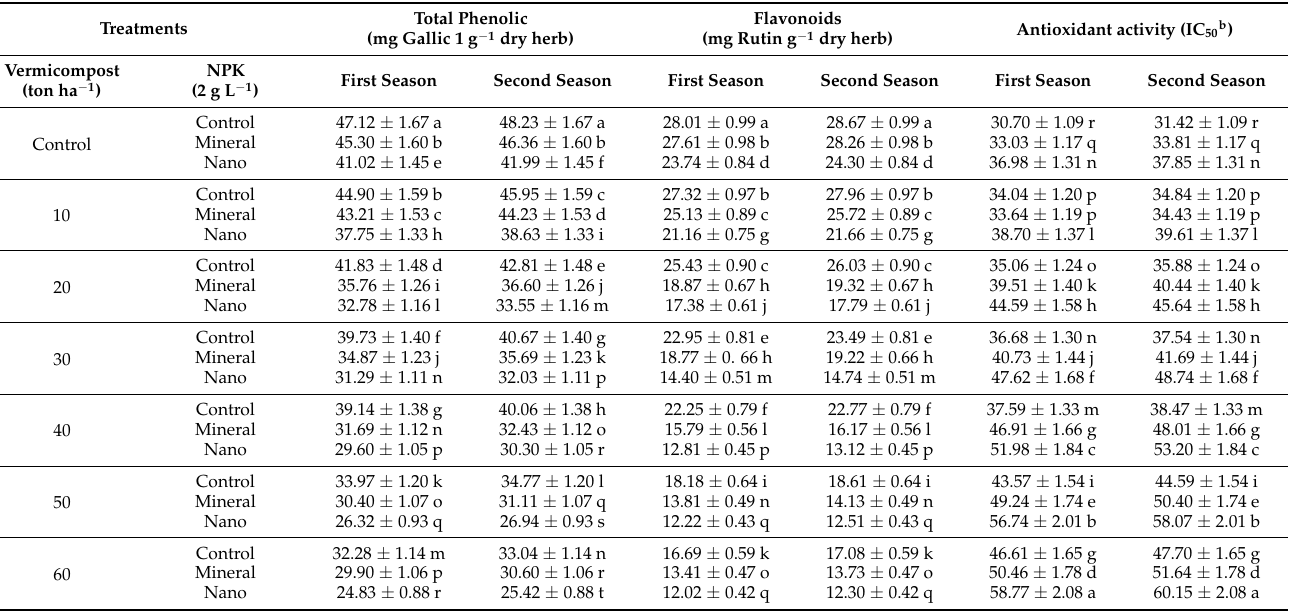
Table 8. The influence of combined treatments of vermicompost and NPK fertilization on the mean values of total phenolic (mg Gallic g − 1 dry herb), flavonoid content (mg Rutin g − 1 dry herb), and antioxidant activity (IC 50b of Moringa oleifera trees in the first and second